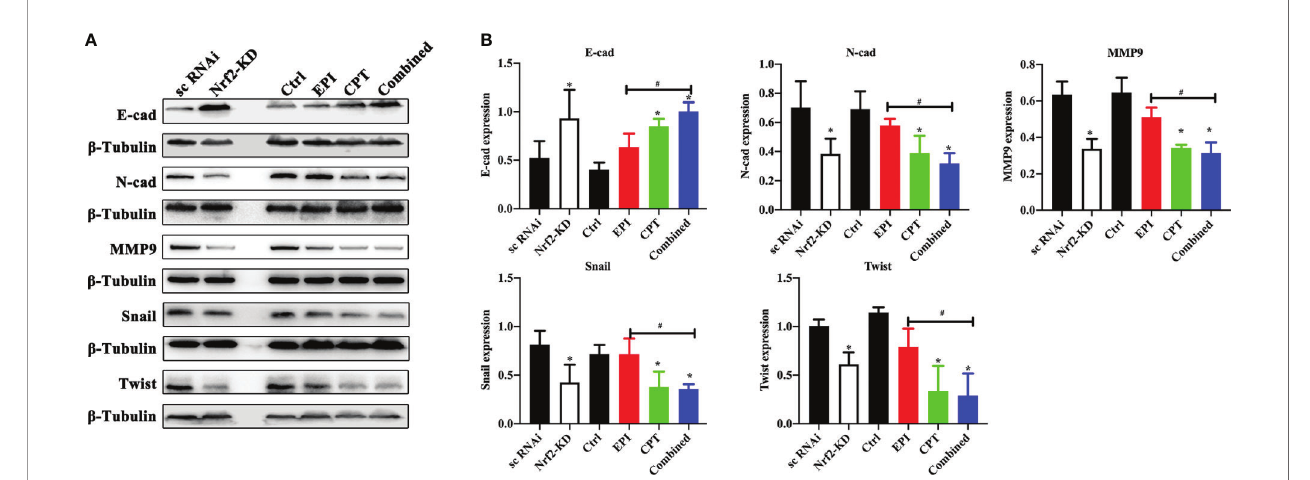
FIGURE 4 | CPT suppressed EMT progress of Huh7 cells. The non-transfected Huh7 cells were treated with EPI and CPT for 48 h. The sc RNAi and Nrf2-KD were transfected with scramble negative control and Nrf2-knockdown RNAi. (A) The expression of E-cadherin (E-cad), N-cadherin (N-cad), MMP9, Snail and Twist was measured by western blot. (B) Densitometry assay of the band in western blot. ß- Tubulin was the internal reference. *P < 0.05, # P <